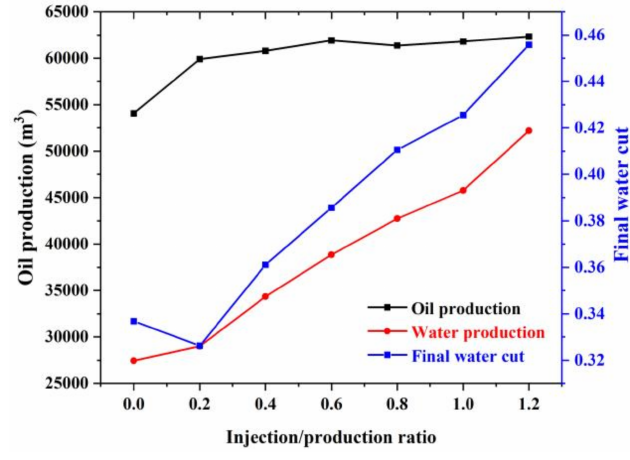
Figure 11. Liquid production and water cut of the well group.